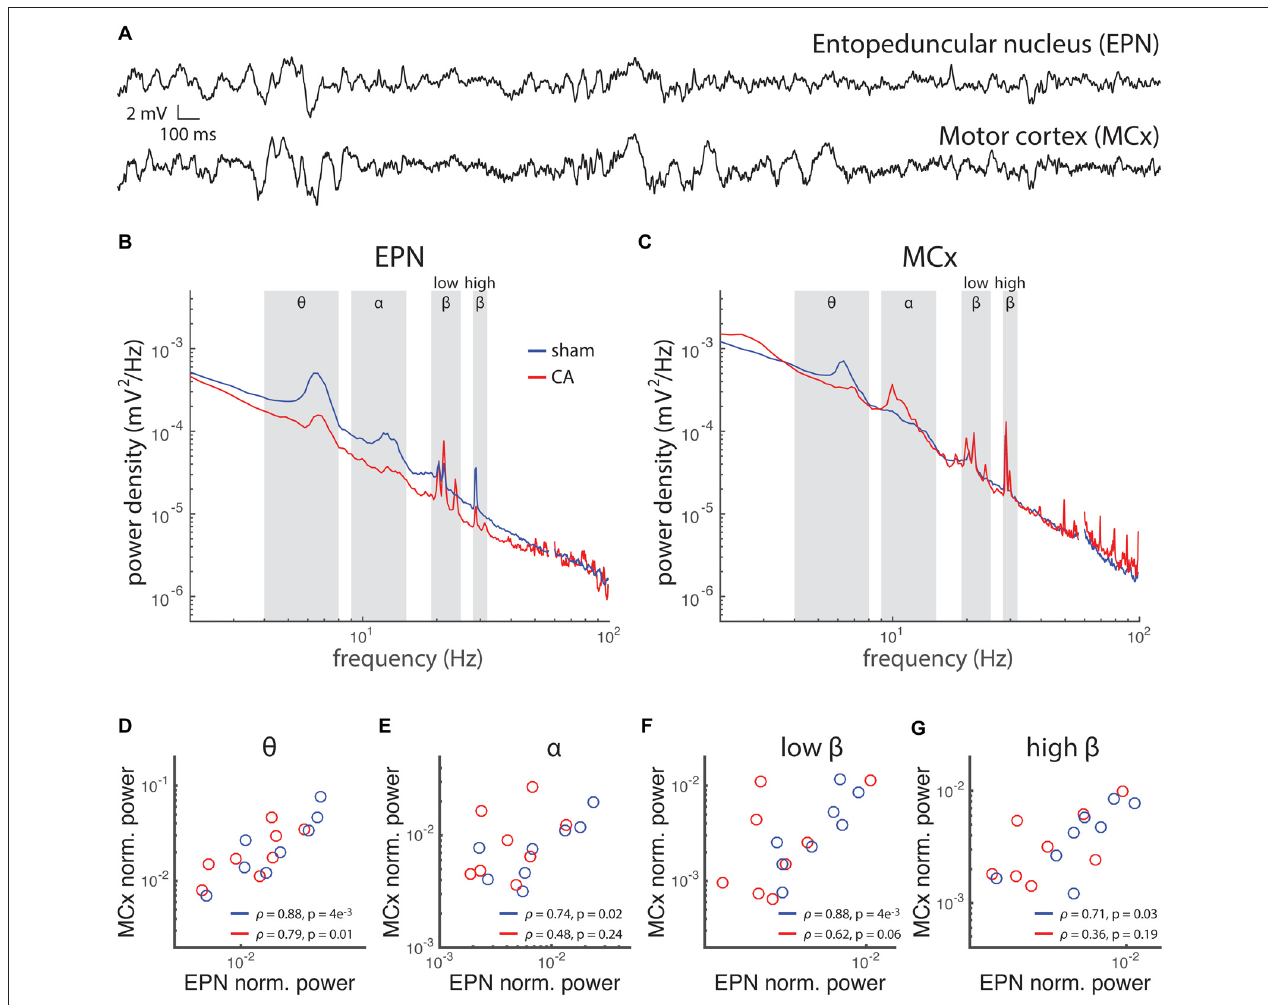
FIGURE 7 | Rhythmic activity and correlation between motor cortex (MCx) and basal ganglia is affected by hypoxic ischemic injury. (A) Local field potentials (LFPs) were simultaneously recorded in the EPN of the basal ganglia and the MCx in rats 6 weeks after injury or sham treatment. (B) The power spectral density of EPN LFPs in sham rats and CA rats exhibit spectral peaks at several frequencies, implying relatively more pronounced rhythms contributing to the LFP fluctuations at those frequencies. The frequency bandwidths are labeled: θ (4–8 Hz), α (9–15 Hz), low- β (19–25 Hz) and high- β (28–32 Hz). (C) The power spectral density of MCx LFPs exhibits relative peaks in the same frequency bandwidths of EPN LFPs. (D–G) Power in each bandwidth was averaged and normalized to the mean power across all frequencies. Average power in MCx was plotted against average power in EPN for each rat. The correlation between MCx and EPN mean power levels in different bandwidth was examined across the rats in our study by calculating the Spearman correlation coefficient of these two area-specific powers. We found that Sham rats had correlated MCx-EPN LFP power levels in the θ , α and low- β ranges, while CA rats had correlated MCx-EPN LFP power levels in the θ band